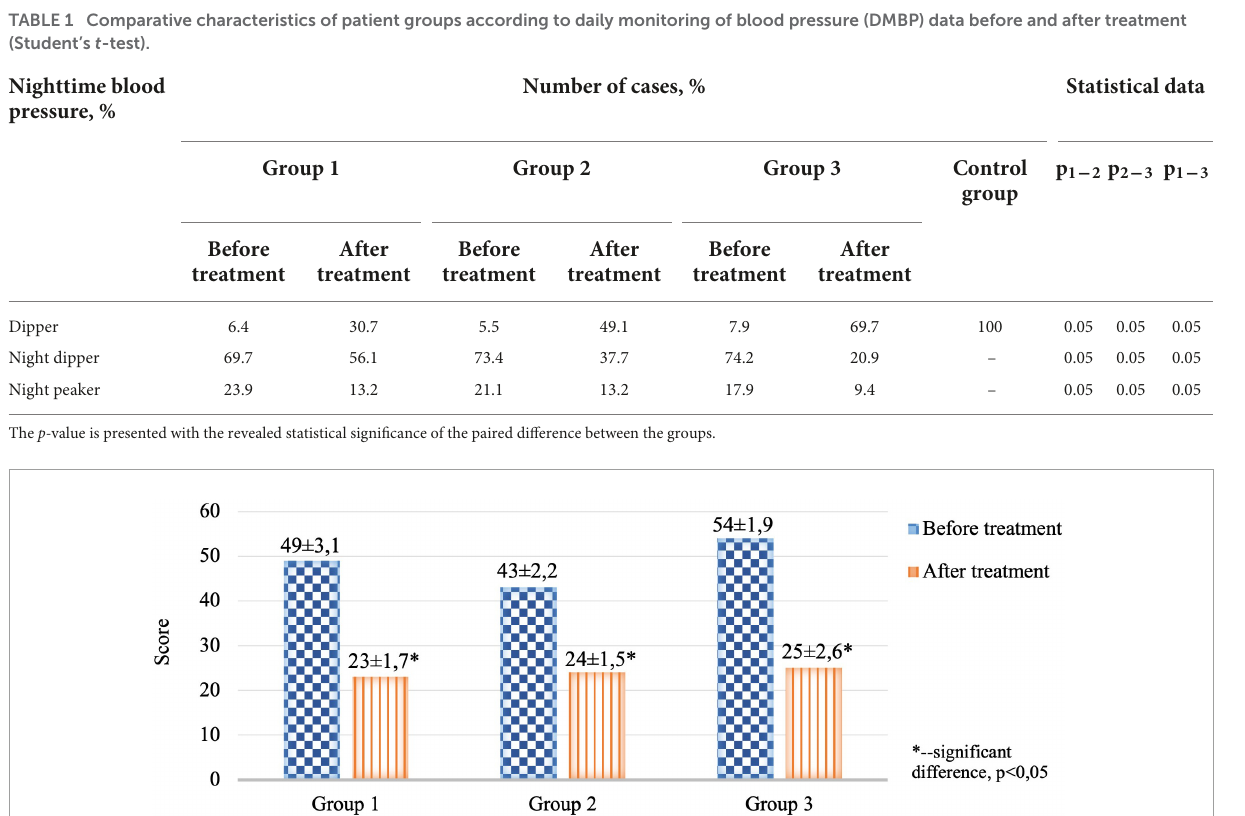
FIGURE4 Comparative characteristics of the results of the CES-D clinical scale in the study groups before and after therapy (score).